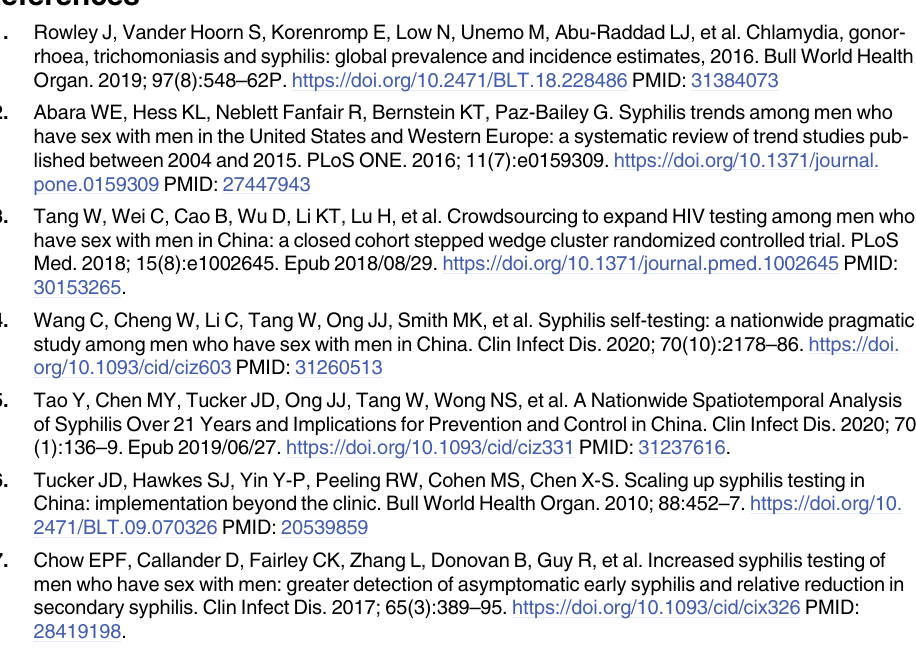
S3 Table. Sensitivity analysis on the uptake of syphilis testing among all participants. S4 Table. Newly identified syphilis infections and linkage to care among men who had syphilis testing during the trial. S5 Table. Syphilis testing by mode: self-test, facility-based test, or